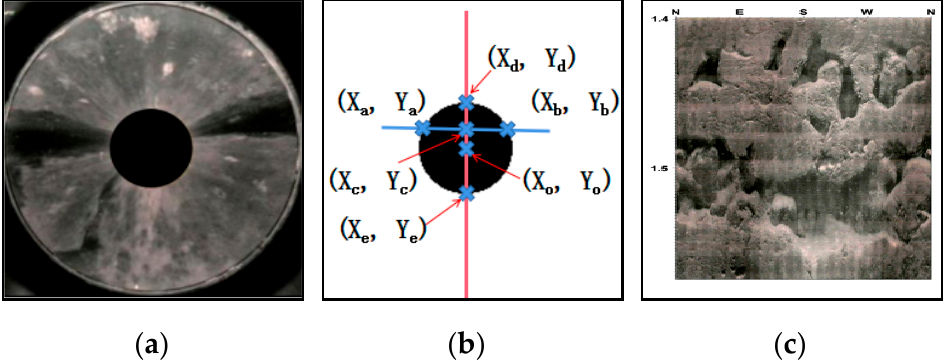
Figure 2. Schematic diagram of borehole image expansion. ( a ) Acquired image, ( b ) center coordinate, ( c ) expansion diagram.